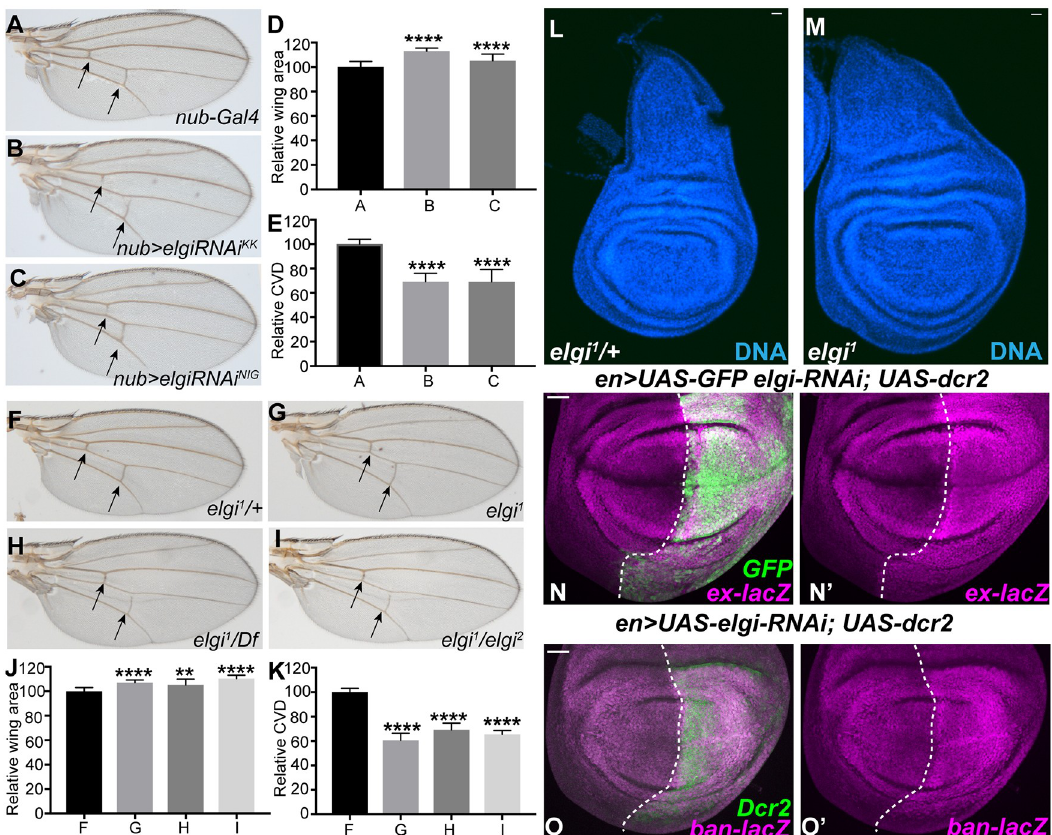
Fig 1. elgi mutant phenotypes. (A-C) Adult male wings from flies expressing nub-Gal4 UAS-Dcr2 control (A), nub-Gal4 UAS-Dcr2 UAS-elgi-RNAi KK (VDRC109617) (B), and nub-Gal4 UAS-Dcr2 UAS-elgi-RNAi NIG (17033R-3) (C). Arrows point to the crossveins. (D) Histogram of relative wing areas in flies of the genotypes in panels A-C, as indicated (normalized to the average area of control wings); mean of B is 112.9, and C is 105.2. (E) Histogram of the ratio of crossvein distance (CVD) to wing length, (normalized to the average CVD/wing length in control wings) in flies of the genotypes in panels A-C, as indicated. (F-I) Adult male wings from elgi 1 /+ (control) (F), homozygous elgi 1 (G), hemizygous elgi 1 /Df(3L) BSC575 (H), trans-heterozygous elgi 1 / elgi 2 (I) flies. Arrows point to the crossveins. (J) Histogram of relative wing areas (normalized to the average area of control wings) in flies of the genotypes in panels F-I, as indicated. Mean of G is 107.1; H is 105.4 and I is 110.4. (K) Histogram of the ratios of crossvein distance (CVD) to wing length, (normalized to the average CVD/wing length ratio of control wings) in flies of the genotypes in panels F-I, as indicated. Data are shown as mean ± SD from measurements of 10–13 wings per genotype. �� P < 0.002 and ���� P < 0.001, (Student’s t test between control and the other genotypes); (L,M) Wing imaginal discs from age matched control elgi 1 /+ and homozygous elgi 1 4 day old third instar larvae. (N-O’) Third instar wing imaginal discs expressing en-Gal4 UAS-dcr2 UAS-GFP UAS-elgi-RNAi and ex-lacZ (N, N’) or ban-lacZ (O, O’) stained for expression of ex-lacZ or ban-lacZ (magenta), with posterior cells marked by expression of GFP or Dcr2. Dashed white line marks the A-P compartment boundary. Scale bar is 33 μ m.